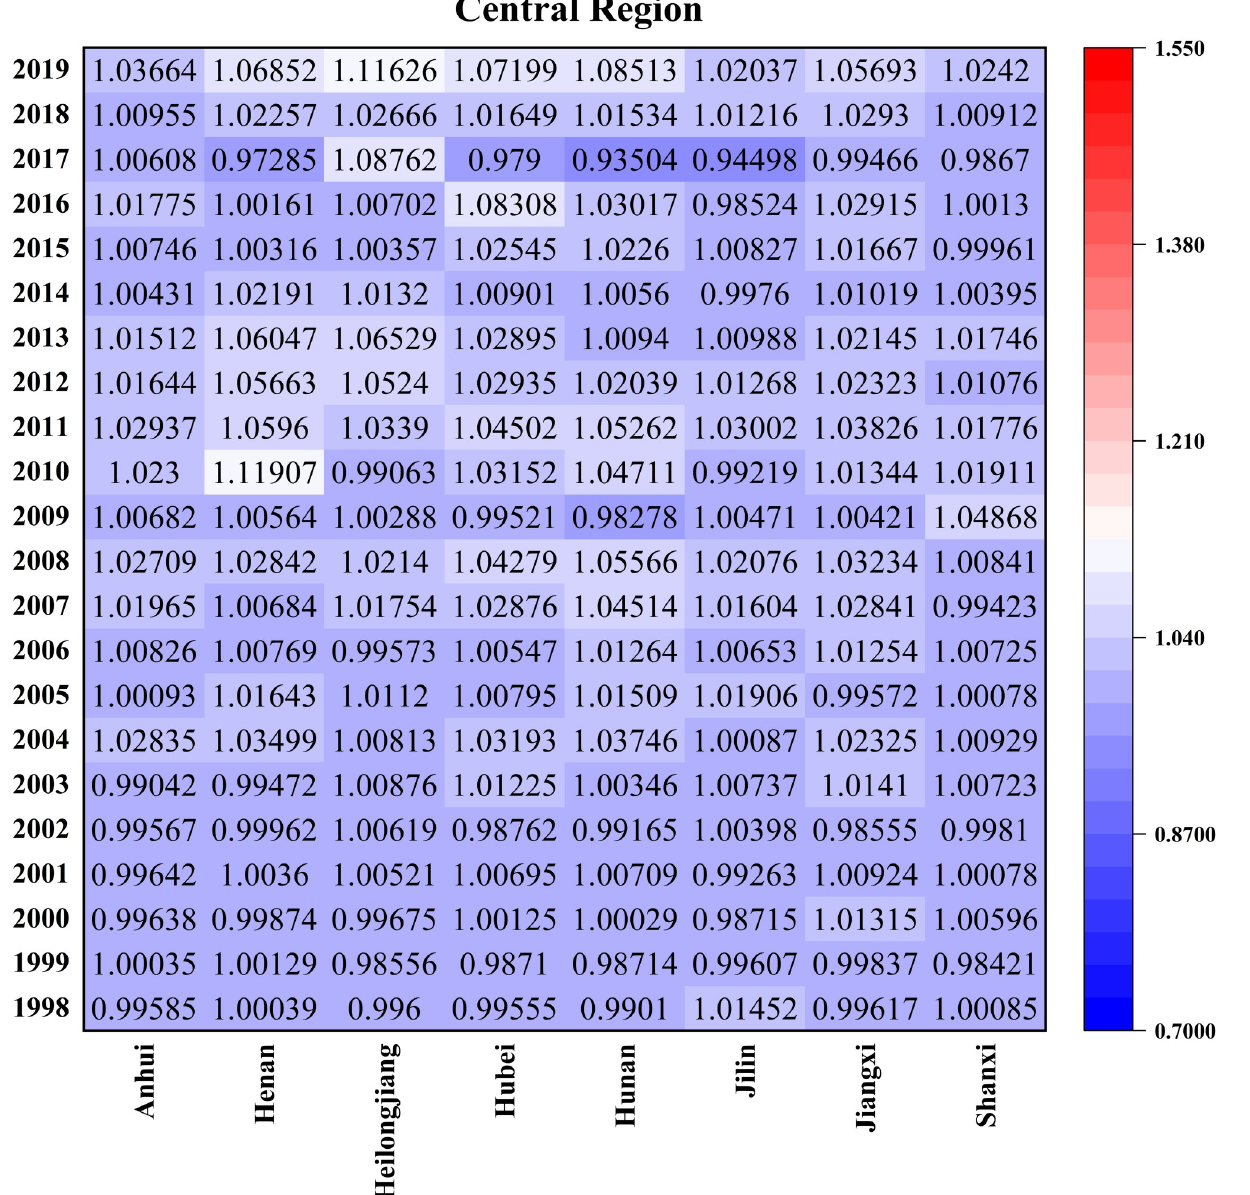
Fig 11 is the semi-box chart of total factor productivity of green agriculture in the eastern, cen- tral and western regions, and each numerical point represents the average value of different provinces for many years.